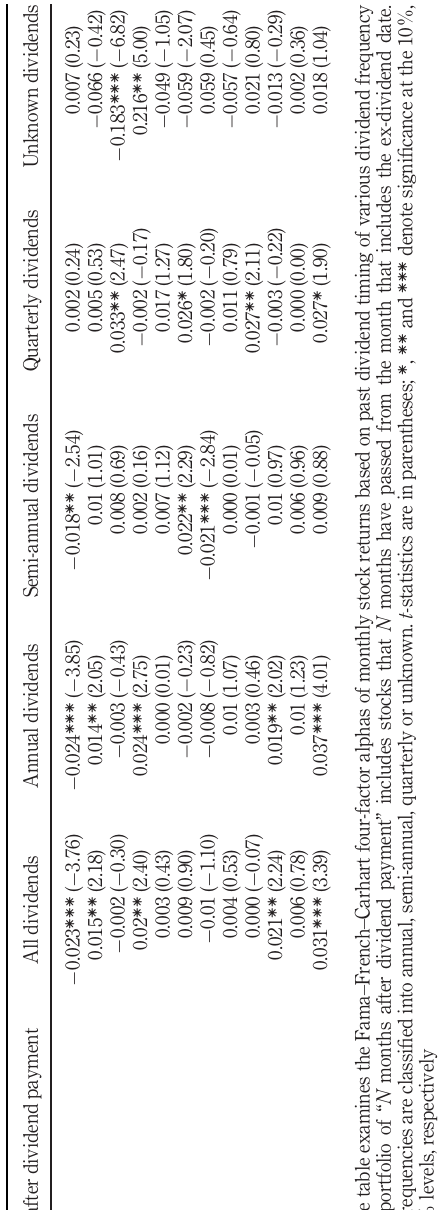
Table 9. Dividend frequency and the risk-return of past dividend